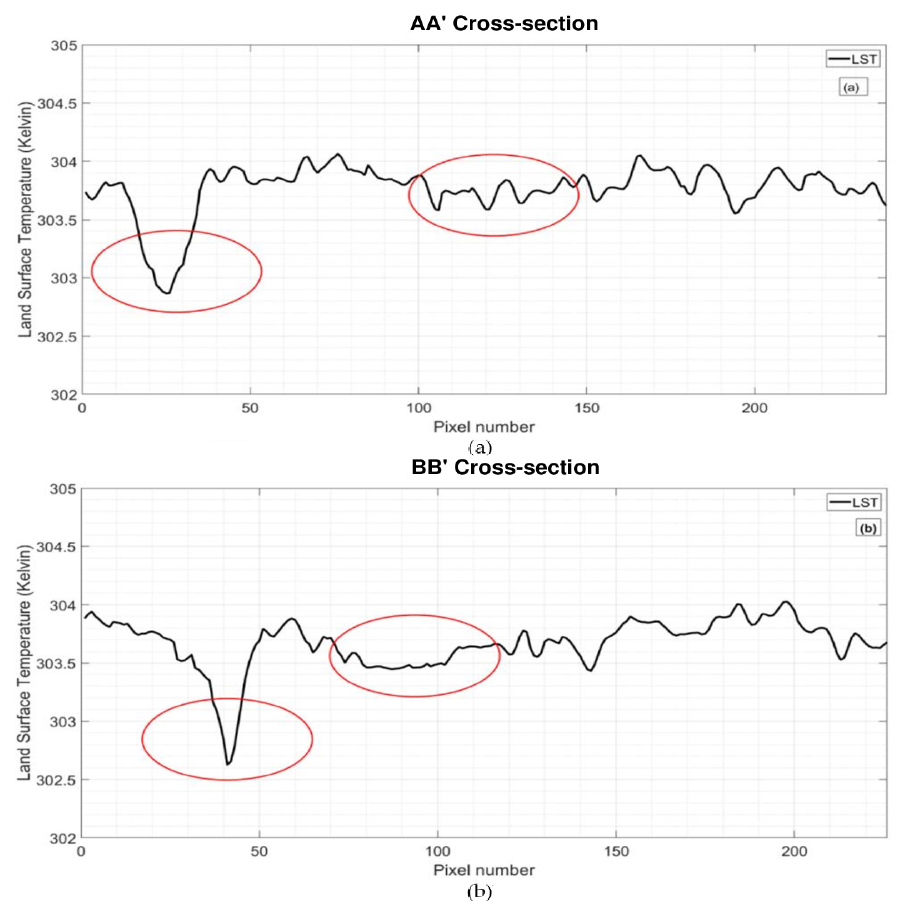
Figure 12. ( a ) AA’ cross-section, ( b ) BB’ cross-section of the LST for Landsat 8 on 3 September